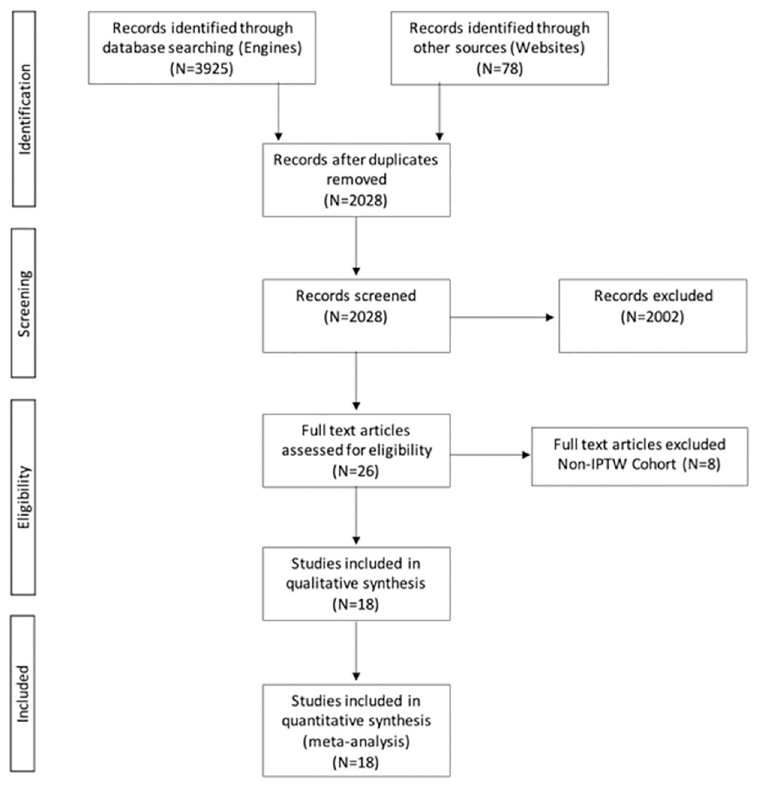
Fig 1. PRISMA 2020 flowchart